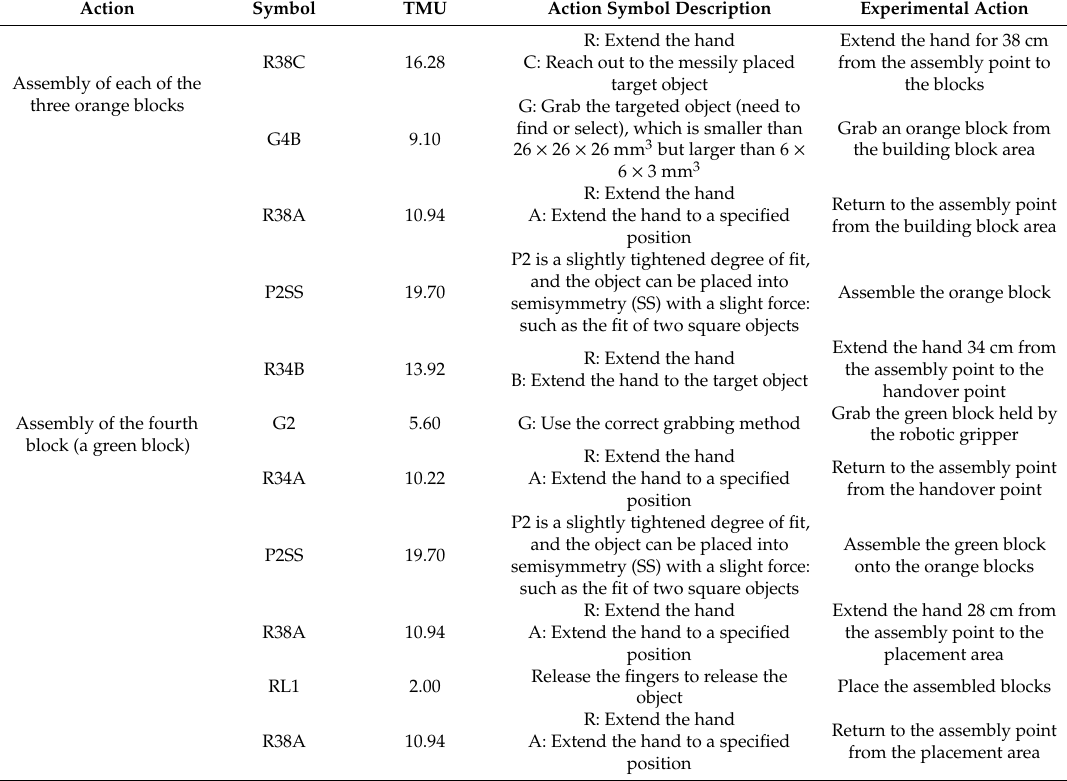
Table 1. Description of block assembly actions and their duration, as calculated using the method-time measurement